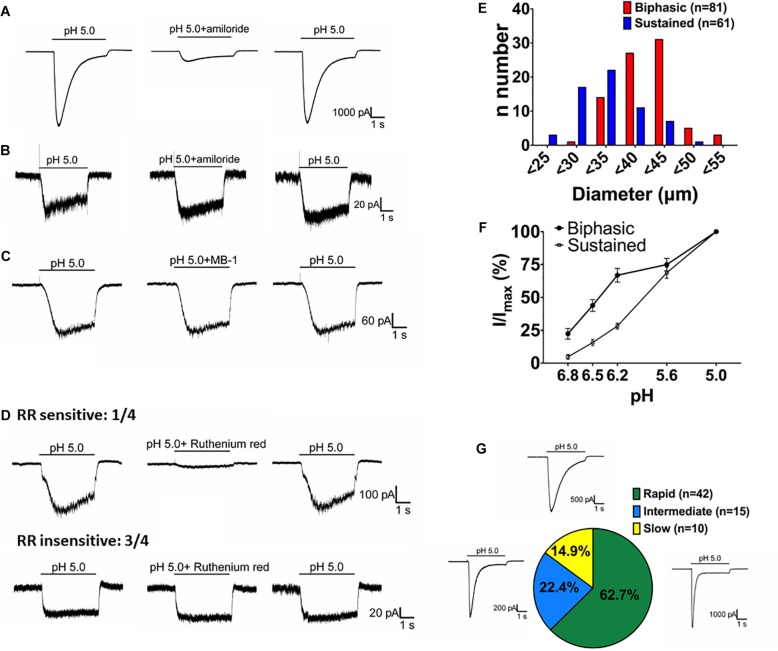
Acid-induced currents in ASIC1b-expressing DRG neurons. (A) Representative current traces of ASIC-like currents in ASIC1b-expressing DRG neurons. Amiloride (100 μM) inhibited the acid-induced transient inward current (n = 5). (B) Representative current traces of acid-induced sustained currents in ASIC1b-expressing DRG neurons (n = 5). (C) Representative current traces of acid-induced sustained currents resistant to mambalgin-1 (1 μM). (D) Representative current traces of acid-induced sustained currents sensitive (n = 1) or resistant (n = 3) to 10 μM ruthenium red treatment. (E) Histograms of DRG neurons by size and acid-induced current types (biphasic, n = 81; sustained, n = 61). (F) pH sensitivity of DRG neurons with biphasic and sustained currents. Peak amplitudes were normalized to that induced by pH-5 artificial cerebrospinal fluid (ACSF) (biphasic, n = 10; sustained, n = 10). (G) The proportion of three subtypes of ASIC-like currents with different desensitization time constants (rapid, <300 ms; intermediate, 300–900 ms; and slow, >900 ms).